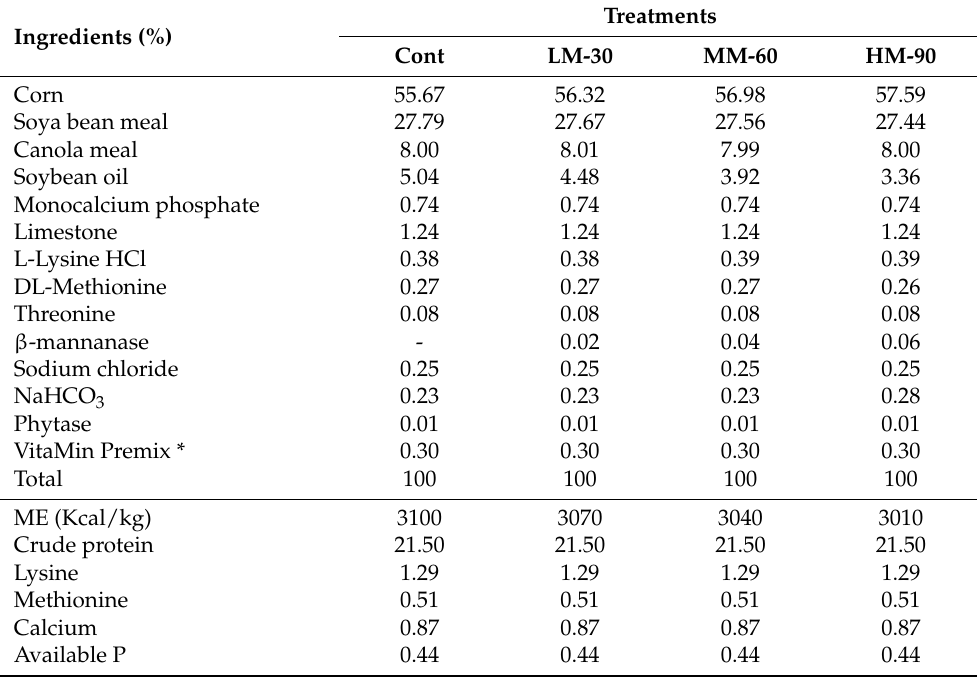
Table 2. Ingredient composition and nutrient profile of grower feeds (8–21 days).